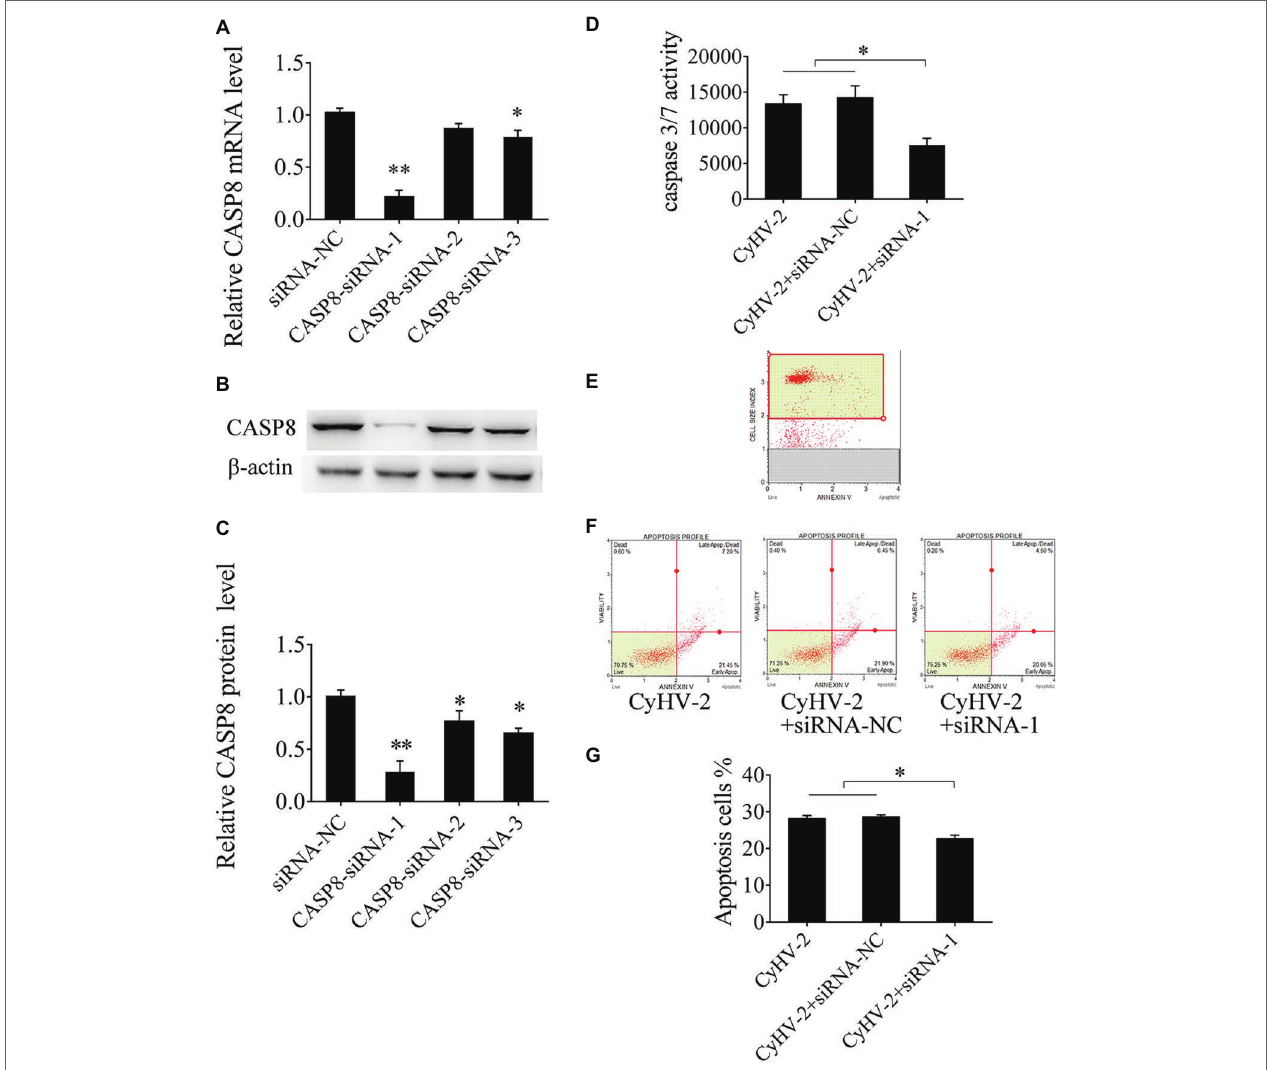
FIGURE 3 | Effect of caspase 8 on CyHV-2-mediated apoptosis. (A,B) Silencing of caspase 8 in GiCF cells by specific siRNA. GiCF cells were transfected with different CASP8 siRNA (CASP8-siRNA-1, CASP8-siRNA-2, and CASP8-siRNA-3) or siRNA NC. After 24 h, CASP8 mRNA levels were detected by qRT-PCR (A) , and protein level was measured by western blot analysis. (C) Bar graphs displaying the CASP8 protein level post-transfection of siRNA. (D) Caspase 8 was downregulated by CASP8-siRNA-1 in virus-infected GiCF cells post infection, and caspase-3/7 activity was assayed using Caspase-Glo 3/7 assay kit. (E) Scatter plots of flow cytometry. (F) Apoptotic cells were assayed using annexin V and caspase-3/7 activity assay (G) . Data represent the means for three independent experiments. ** p < 0.01; * p <